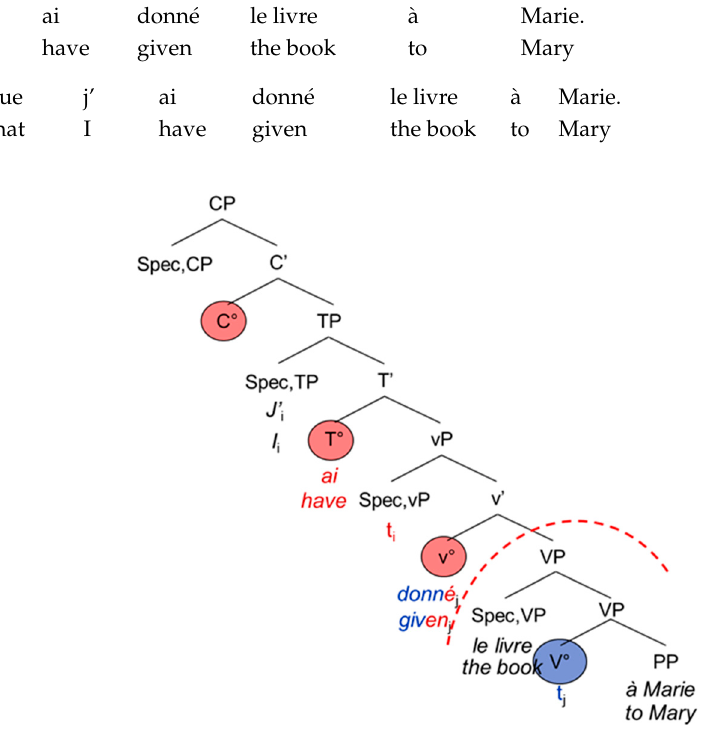
Figure 5. Structure of the French main clause.